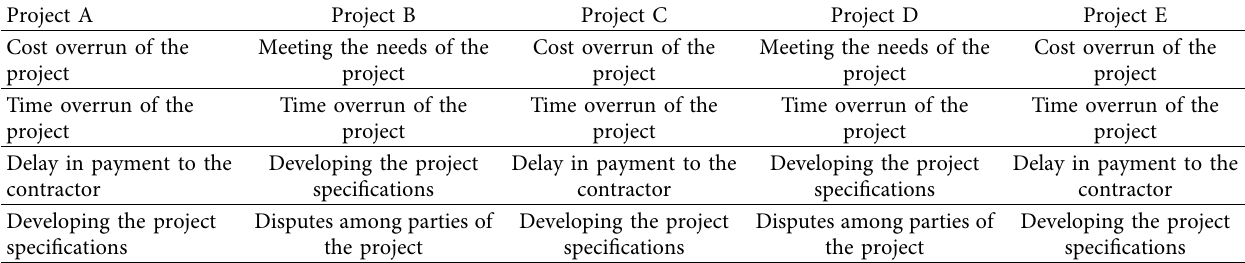
Table 3: Extract carried out on the impacts of change orders in the studied